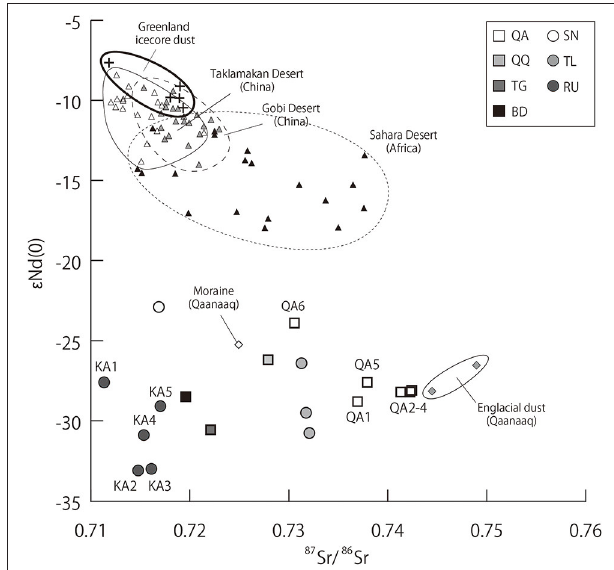
FIGURE 3 | Sr – Nd isotopic ratios of silicate minerals in cryoconites and those of moraine and englacial dust on and around the Qaanaaq Glacier, and loess and sand reported in the Asian and African